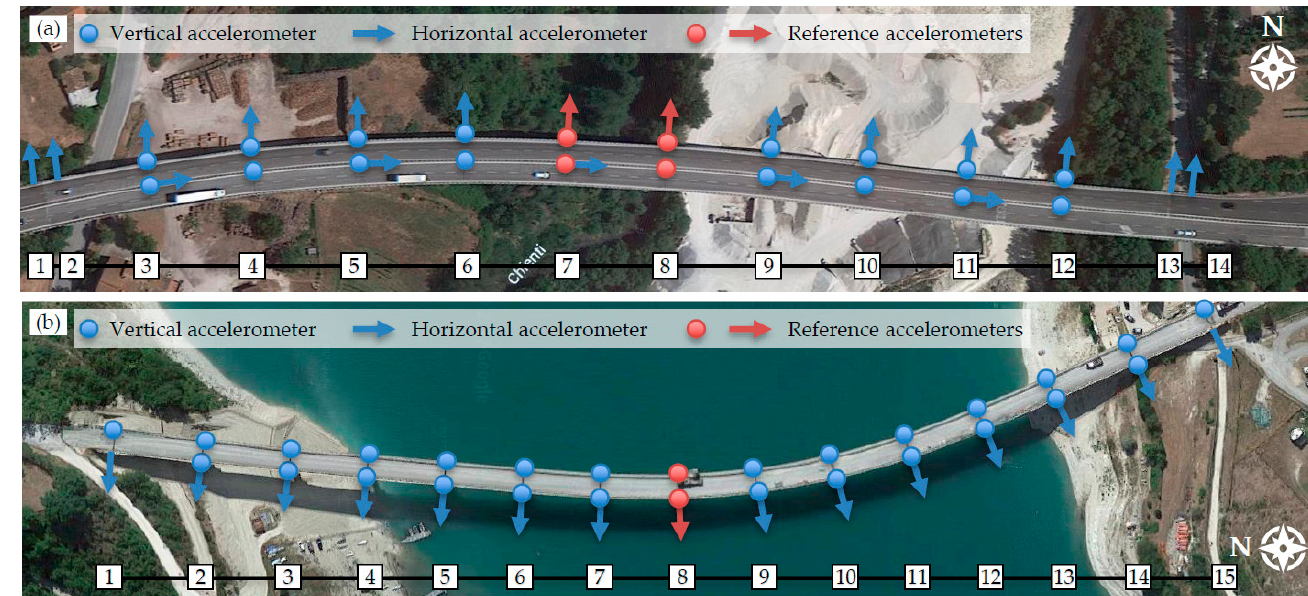
Figure 6. Sensor configurations for AVTs and measured sections: ( a ) the B1 and ( b ) the B2 bridge.